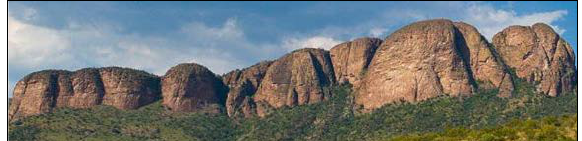
Figure 5: Marakele National Park (Source M Jordaan, 2011)